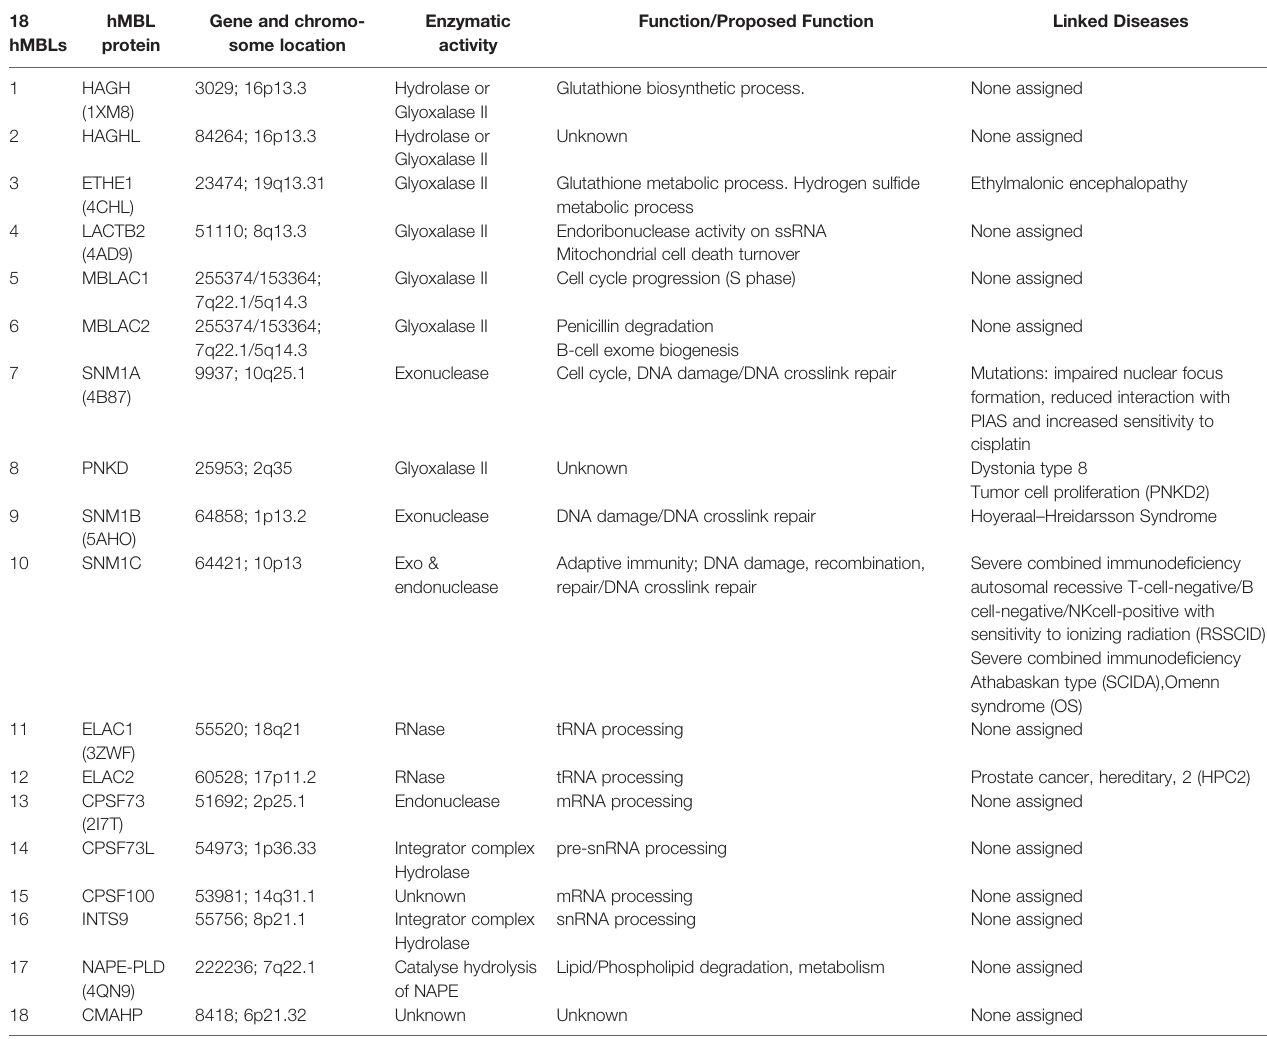
TABLE 1 | Human metallo beta lactamases function